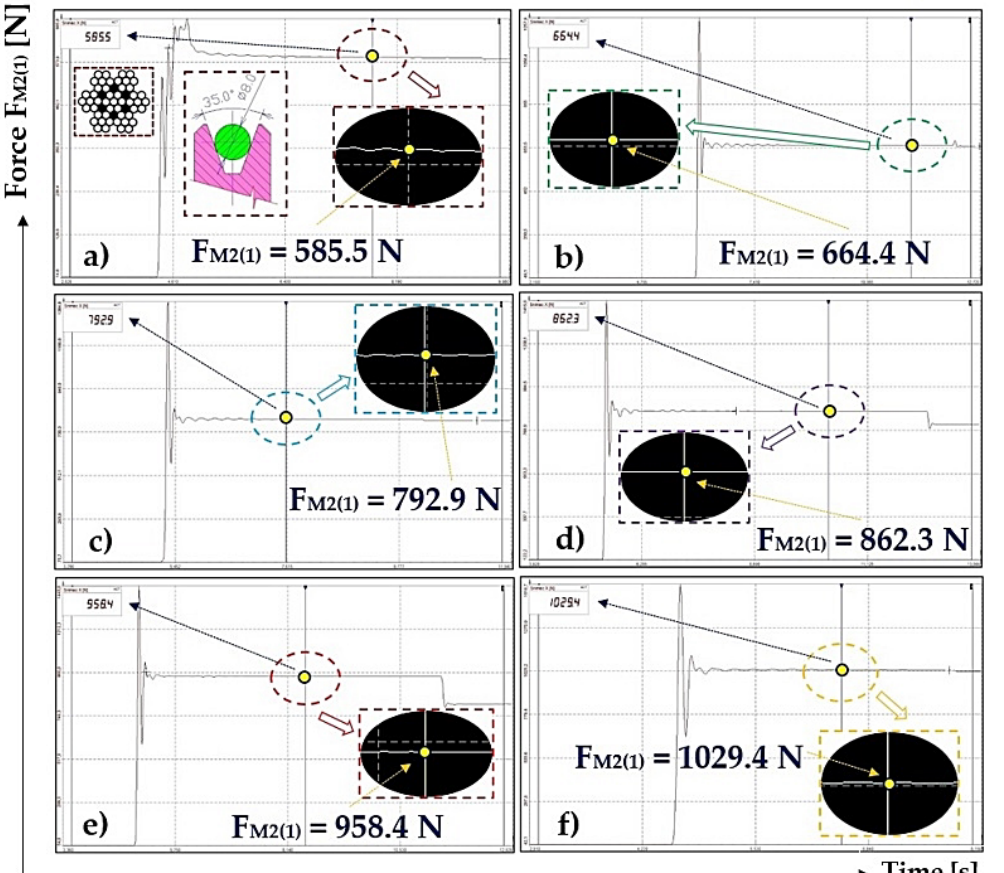
Figure 11. Measured tensile forces F M2(i) [N] processed by DeweSoft ® software for ϕ8 mm rope, V-shaped groove, clean condition (for weight of weights G z [N] ( a ) 49 N, ( b ) 98 N, ( c ) 147 N, ( d ) 196 N, ( e ) 245 N, ( f ) 294 N).